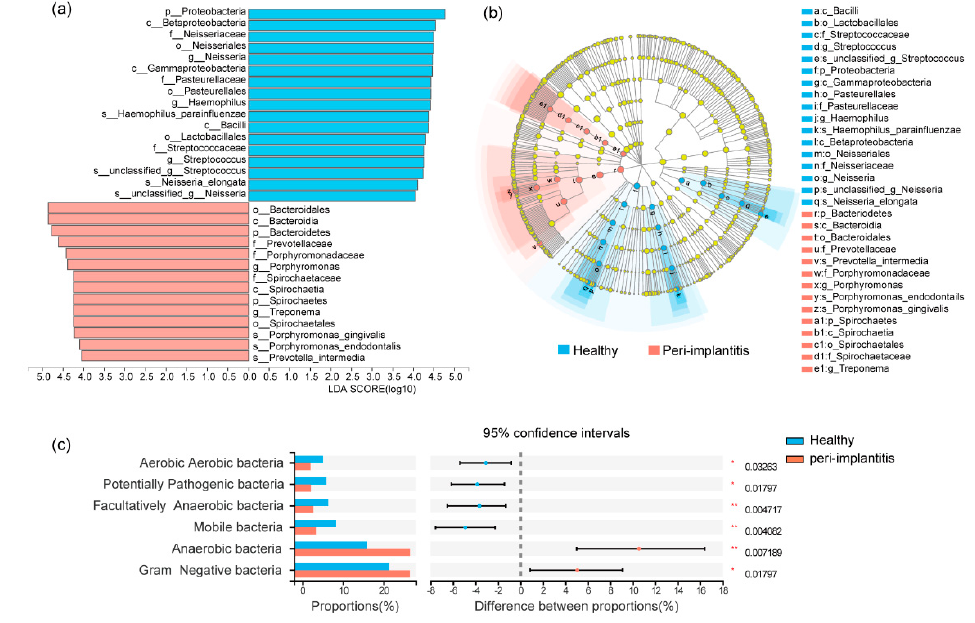
Figure 2. Linear discriminant analysis effect size (LEfSe) analysis of the healthy implants and peri − implantitis. ( a ) Linear discriminant analysis (LDA) represented statistical and biological differences between healthy implants and peri − implantitis (LDA > 4.0, p < 0.05). ( b ) The cladogram showed microbial differences between healthy implants and peri − implantitis at all phylogenic levels. ( c ) The predicted phenotype of the microbiota between healthy implants and peri − implantitis. * p < 0.05, ** p < 0.01.